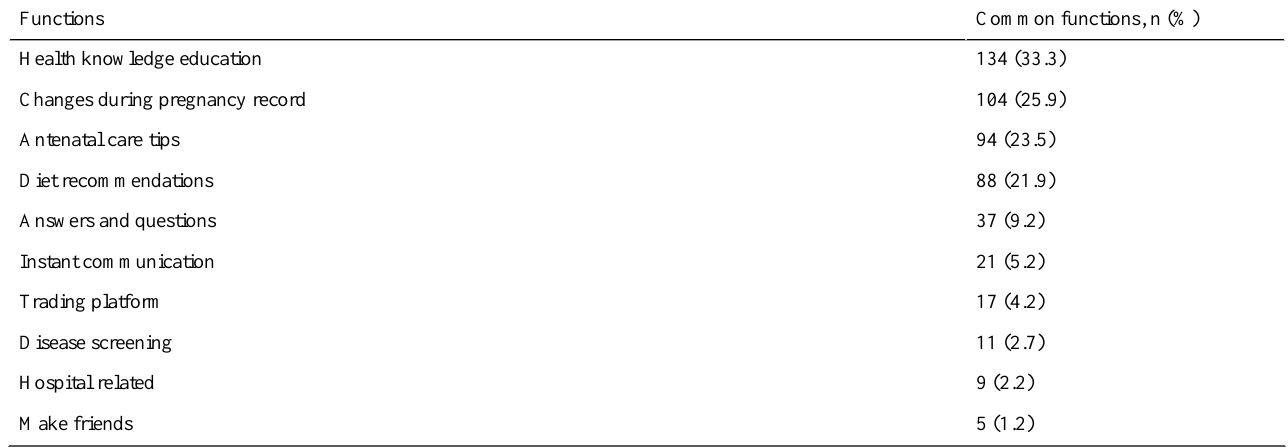
Table 5. Common functions of antenatal care